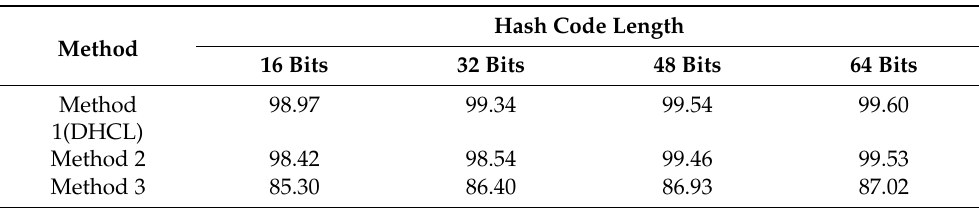
Table 5. Results of evaluation experiment on UCMD. DHCL achieved the best result, followed by method 2, and method 3 achieved the worst result.